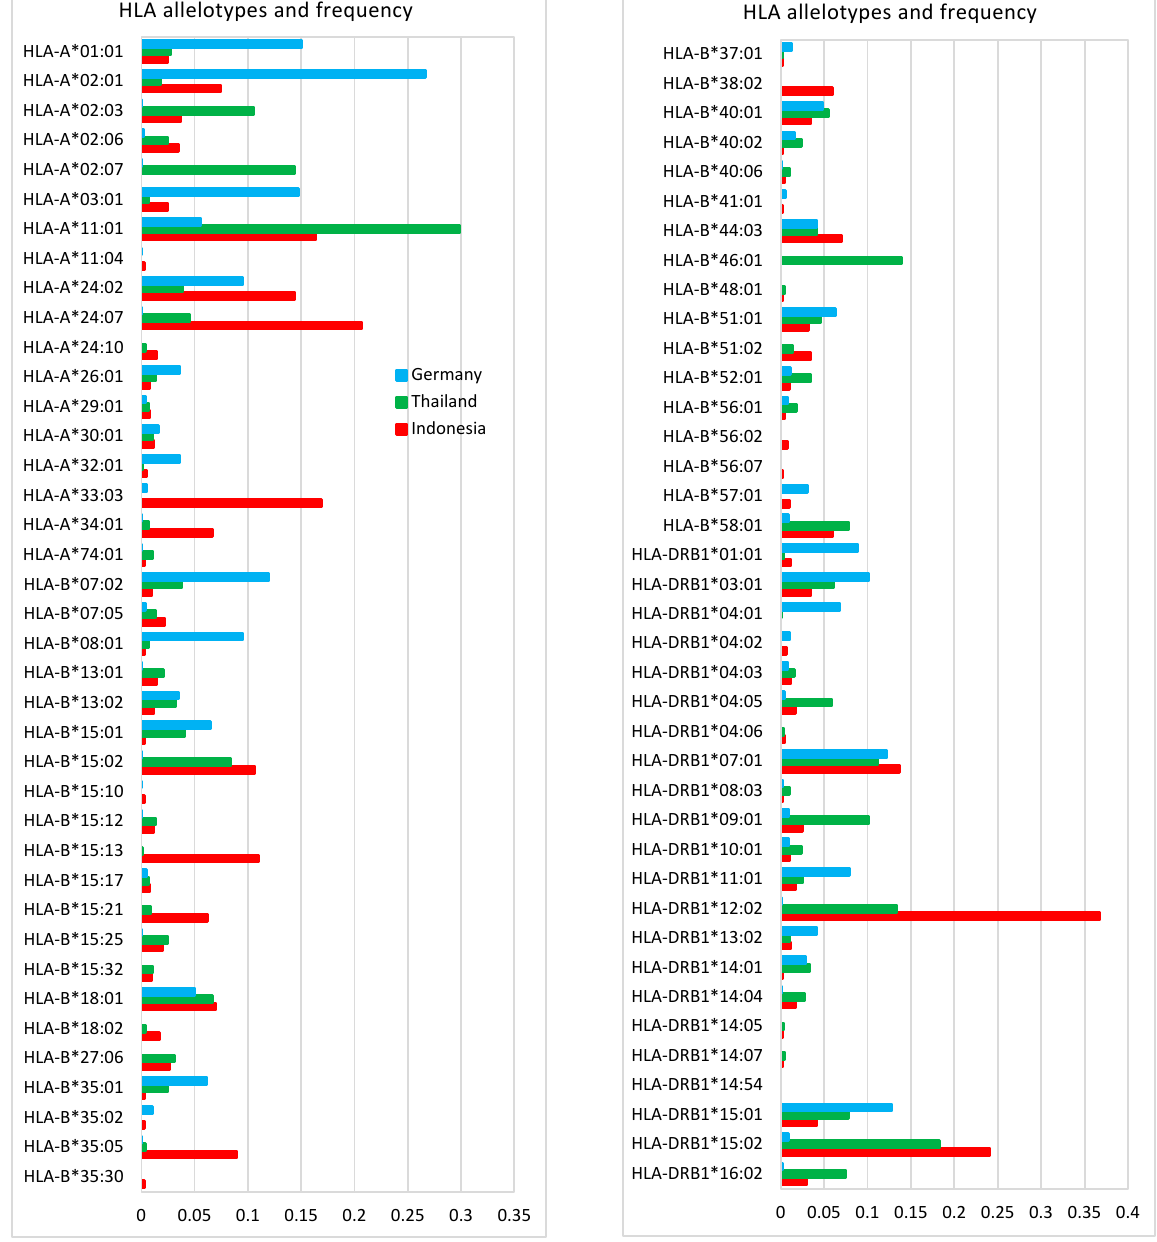
Figure 3. Indonesian HLA alleles and frequency. There were 56 HLA Class I and 22 HLA Class II alleles included in the study. The allele frequency in the Indonesian population (red bar) was compared to those in Thailand (Green bar) and Germany (Blue bar).